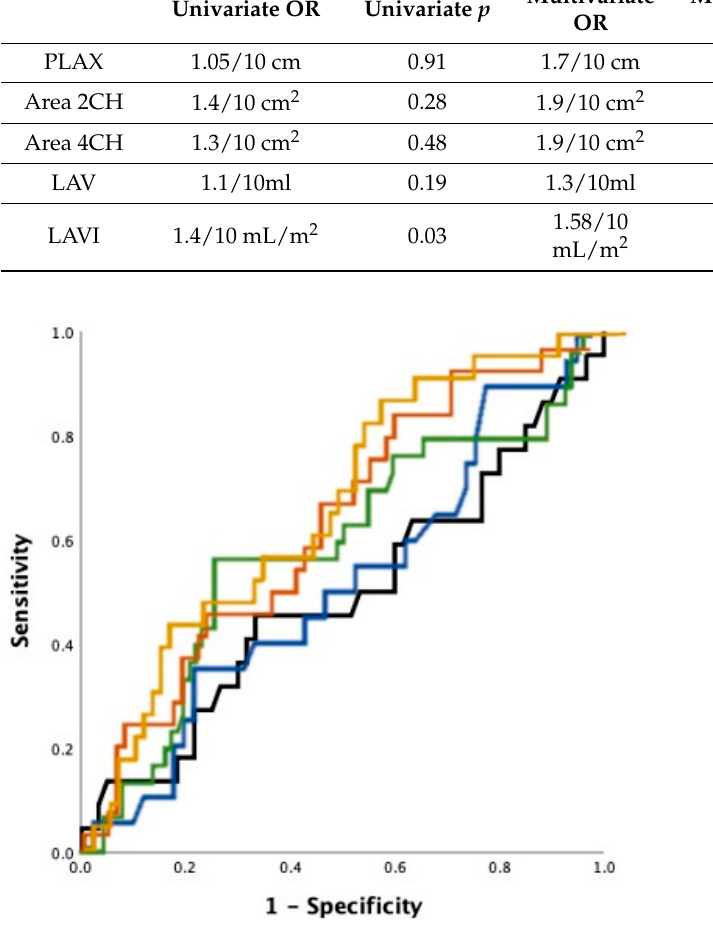
Table 2. Statistical analysis: Univariate and multivariate analysis of LA measurements. Univariate OR Univariate p Multivariate OR Multivariate p